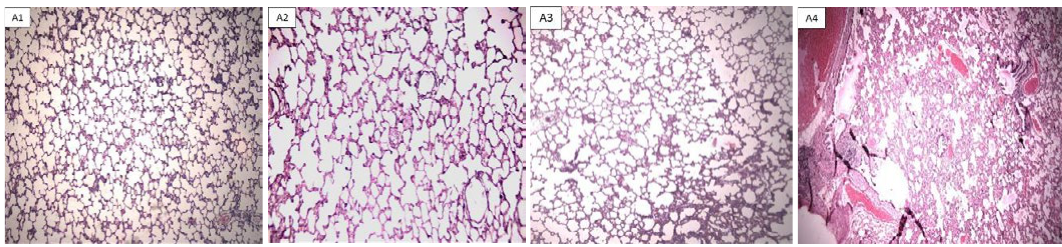
Fig. 2. Photomicrographs of lung sections obtained from rats exposed to different concentrations of IONs. (A2, A3, A4) control rats received 50, 500, 5000 mg/kg of IONs, respectively (A1, A2, A3): normal lung, A4: Hyperemia, interstitial thickening, hemorrhage and inflammation in lungs, (Staining with hematoxylin and eosin). Magnification: 40 x for panels.